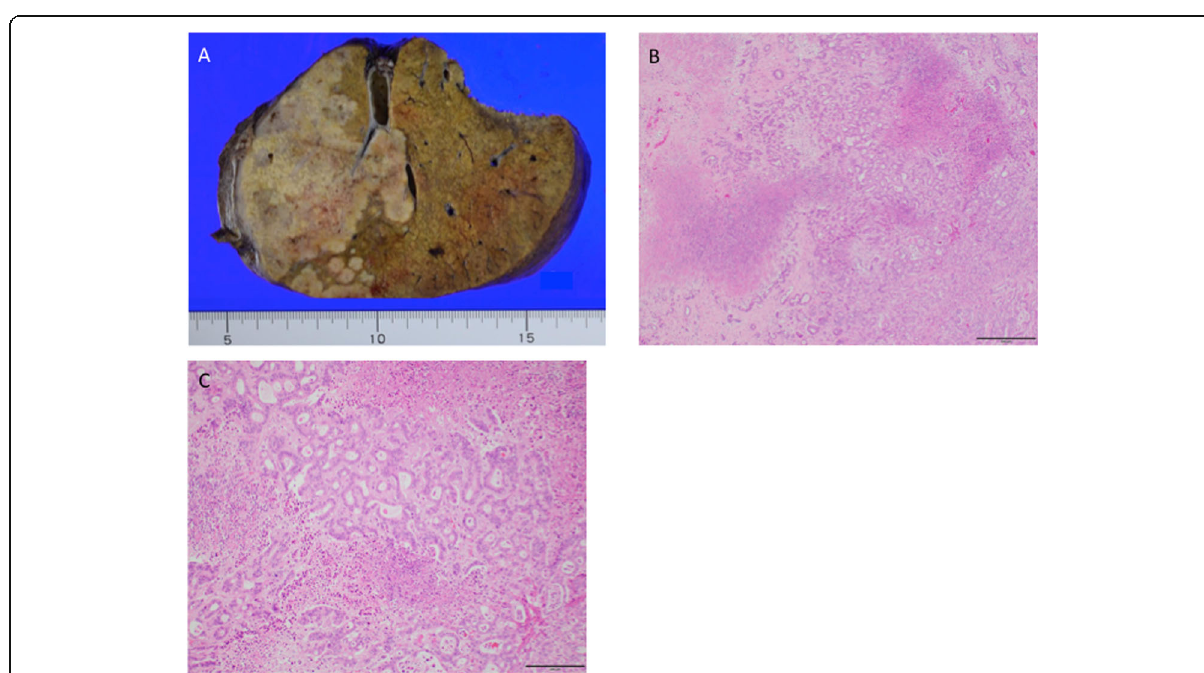
Fig. 2 Intrahepatic cholangiocarcinoma. a Cut surface of the formalin-fixed liver with solid masses in the right lobe. b Hematoxylin and eosin staining. Magnification, × 40. Scale bar, 500 μ m. c Hematoxylin and eosin staining. Magnification, × 100. Scale bar, 200 μ m